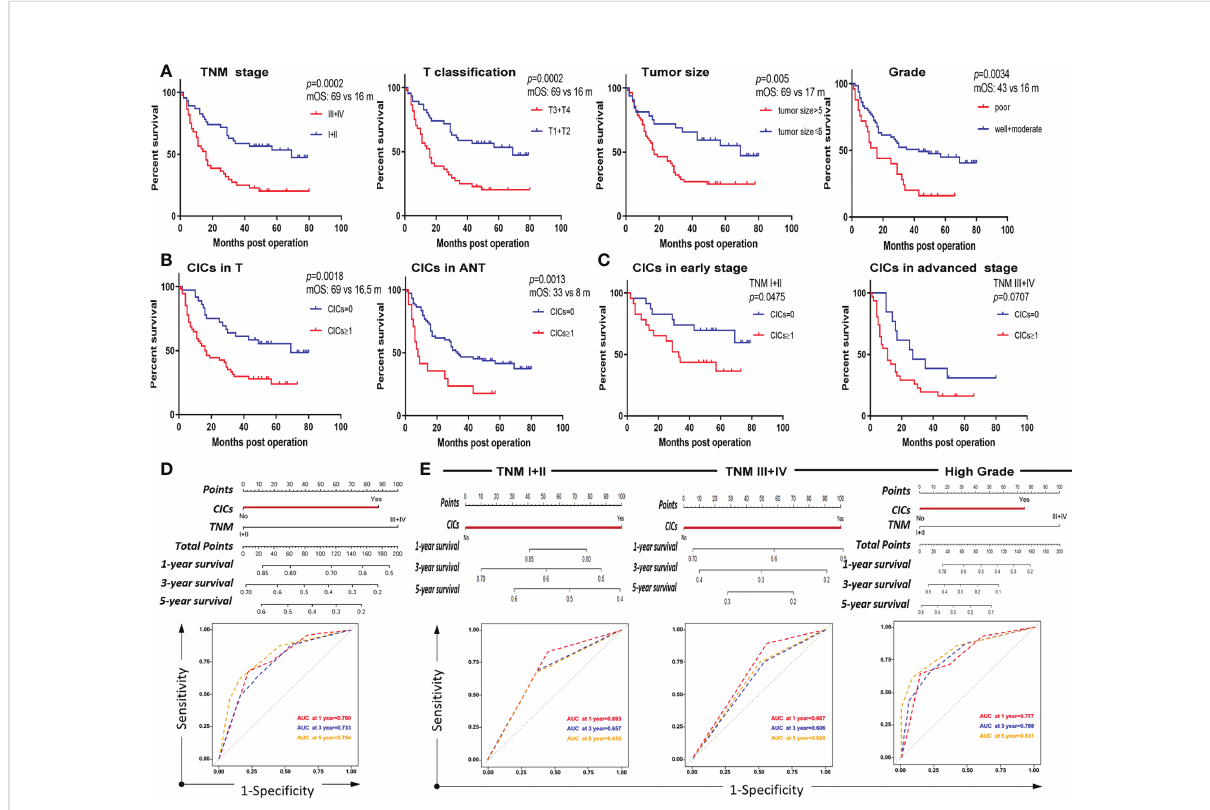
FIGURE 4 CICs selectively impact overall survival of a certain group of patients with HCC. (A) Survival analysis of patients with HCC strati fi ed by TNM, T classi fi cation, tumor size, and histological grade, respectively. (B) The presence of CIC formation (CICs ≥ 1/core) both in tumor (left) and para-tumor (right) tissues is associated with shorter patient survival by Kaplan – Meier plotting of data from TMA staining. (C) The presence of CIC formation (CICs ≥ 1/core) in tumor (left) but not in para-tumor (right) tissues is associated with shorter patient survival by Kaplan – Meier plotting of data from TMA staining. (D) Nomogram and AUC analysis with two independent prognostic factors (TNM stage and CICs). (E) Nomogram and AUC analysis in a cohort of patients strati fi ed by TNM stage (I+II vs. III+IV) (left and middle) or histological grade (well + moderate) (right).